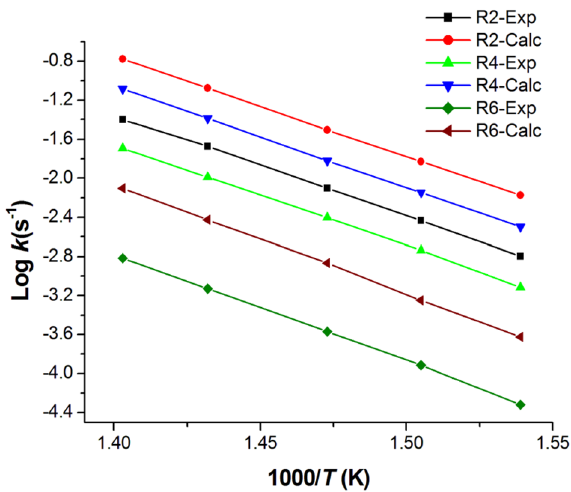
Figure 11. Comparison of the calculated high-pressure limit rate coefficients (Log ( k )s −1 ) dominant reactions (R2, R4, R6) at CBS-QB3//BMK/6–31+G(d,p) level with Exp., Al-Awadi et al. 14,16 .